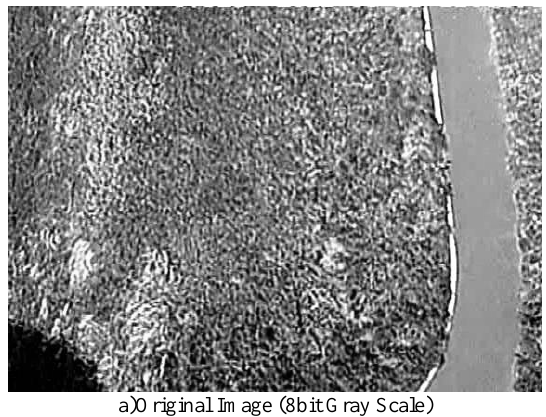
Figure 3. Orientation Code (N = 16)